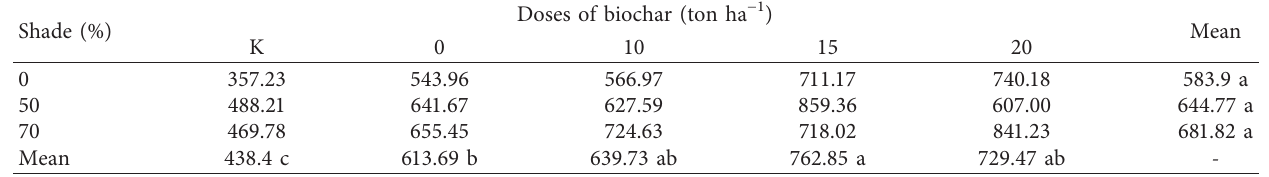
Table 10: Effects of biochar and shade application on nitrate (mg/kg).